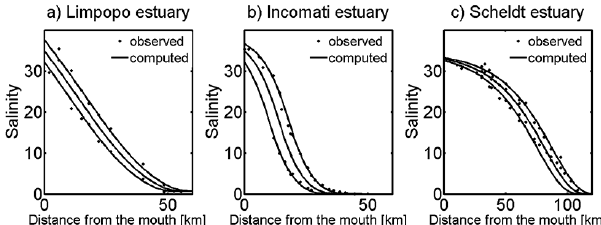
Figure 2. Measured (dots) and simulated (line) longitudinal salin- ity distribution at high water slack, low water slack and for tidal average conditions for the three main types of alluvial estuaries: (a) Limpopo (prismatic), (b) Incomati (mixed type) and (c) Scheldt (funnel-shaped). All data are available at http://salinityandtides.